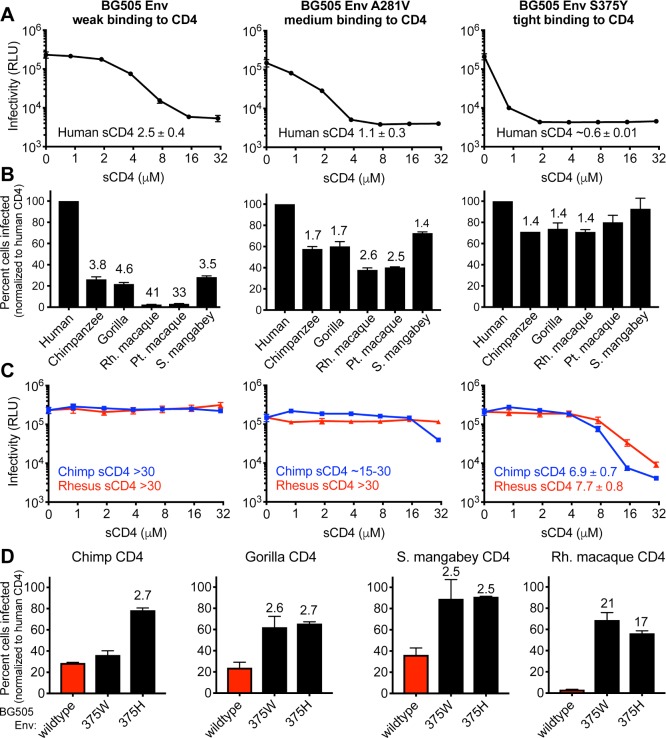
An early Env engineered to have weak, medium, or tight binding to CD4 becomes progressively more promiscuous in its use of primate CD4 receptors.(A–C) Amino acid substitutions were introduced into the BG505 Envelope (Env) at position 281 and 375. The headers at the top describing these mutations pertain to panels A, B, and C. In each column, the indicted Env was pseudotyped onto Q23ΔEnv-GFP. (A) Each of the three viruses was preincubated with increasing concentrations of human soluble CD4 (sCD4) and then used to infect TZM-bl cells, which are HeLa CD4/CCR5 cells that express luciferase in response to HIV-1 infection and tat expression, read in relative light units (RLUs). Error bars represent the mean + SD from one biological replicate, representative of two independent experiments. Error bars are not plotted in instances in which the size of the error bar is less than the symbol size. IC50 values are listed on each panel, for which the mean and SD values reflect the variation of the IC50 calculations from two independent experiments. (B) Cells stably expressing the indicated CD4s (x-axis) and human CCR5 were infected with each virus. The percent cells infected (GFP-positive) was measured by flow cytometry and normalized to the percent infected with human CD4. Error bars represent the mean + SEM from two independent experiments, each with three technical replicates. Values above error bars represent fold decrease relative to human CD4 for those samples that passed significance thresholds (one-way ANOVA for repeated measures effect, Dunnett’s test; P < 0.05). (C) Same as panel A but with chimpanzee and rhesus macaque sCD4 instead of human sCD4. (D) Two additional single point mutations were introduced into the BG505 Env, which have also been shown to increase binding affinity for CD4 [77]. These Envs were pseudotyped onto Q23ΔEnv-GFP and used to infect cells stably expressing the indicated CD4 (top of each graph) and human CCR5. The percent cells infected (GFP-positive) was measured by flow cytometry and normalized to the percent infected with human CD4. Error bars represent the mean + SEM from two independent experiments, each with two to three technical replicates. Values above error bars represent fold increase relative to wildtype BG505 Env for those samples that passed significance thresholds (one-way ANOVA for repeated measures effect, Dunnett’s test; P < 0.01). Data associated with this figure can be found in the supplemental data file (S4 Data). CCR5, C-C motif chemokine receptor 5; GFP, green fluorescent protein.